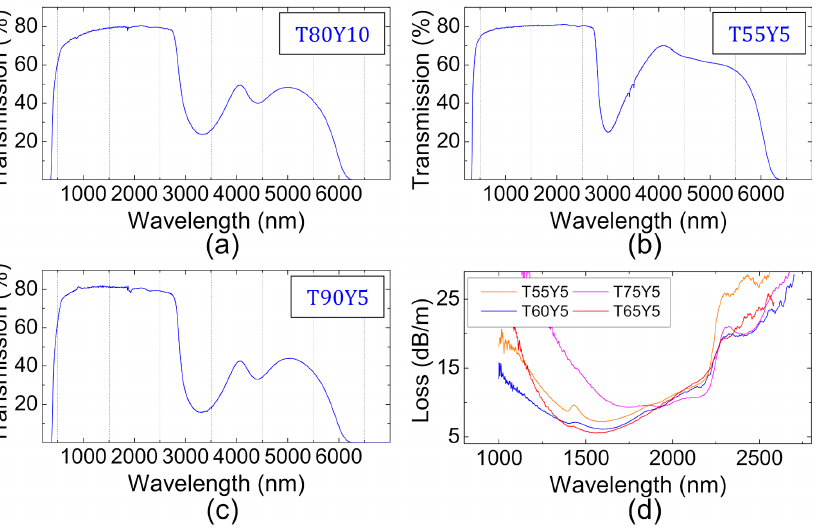
Figure 5. Bulk glass transmission from UV up to the mid-IR for a ( a ) 4.38 mm thick T80Y10 sample, ( b ) 4.47 mm thick T55Y5 sample and ( c ) 4.42 mm thick T90Y5 sample. ( d ) The optical attenuation curve of various single-material TZY glass